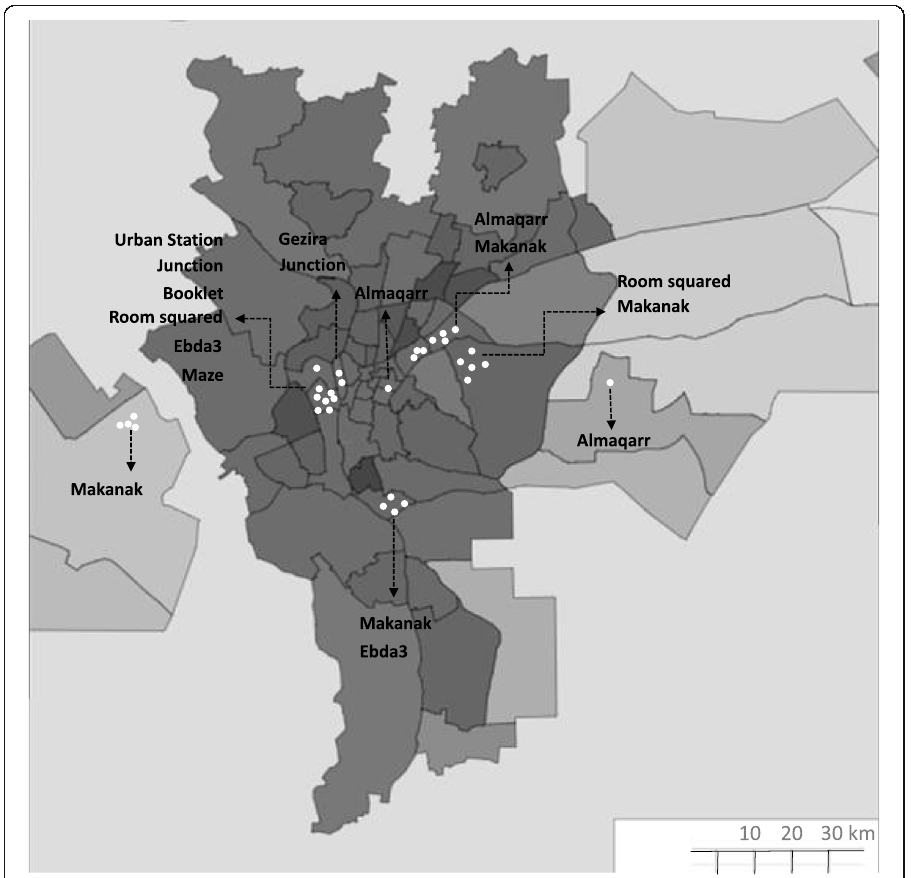
Fig. 1 Locations of co-working spaces from which co-founders and managers were interviewed. Map source https://www.citypopulation.de , elaboration by